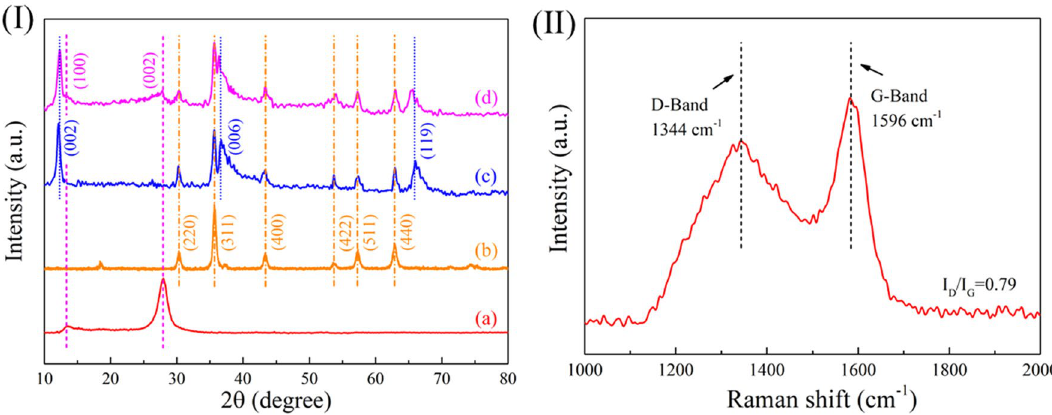
Figure 3. ( I ) XRD patterns of pure g-C 3 N 4 ( a ), Fe 3 O 4 microspheres ( b ), Fe 3 O 4 /C/MnO 2 flower-like microspheres ( c ) and